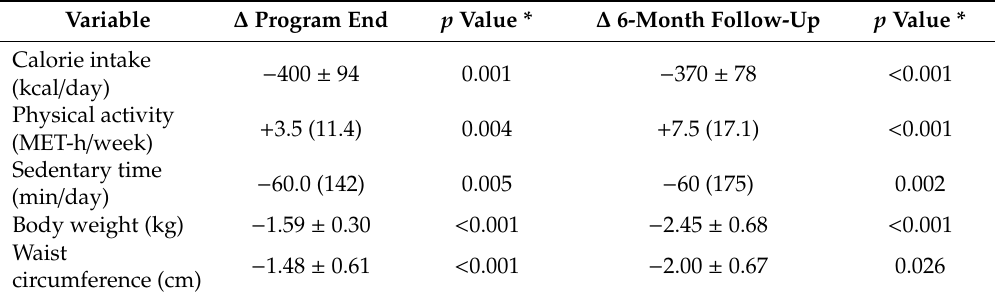
Table 2. Changes in behavioral and anthropometric parameters in response to the motivational interviewing program.